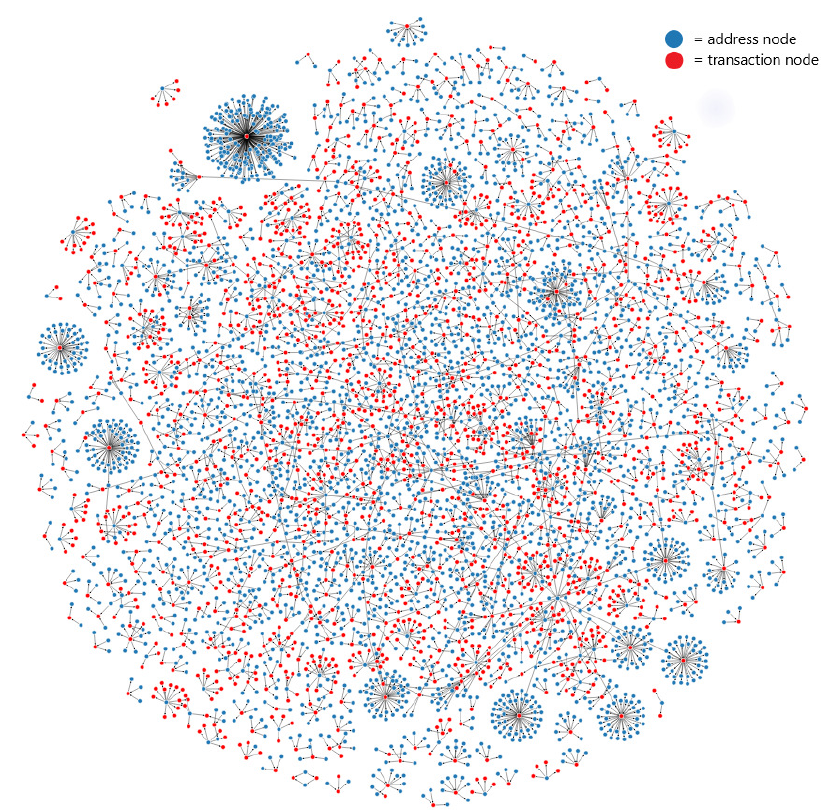
Figure 1. Address-transaction graph computed with one block of the Bitcoin